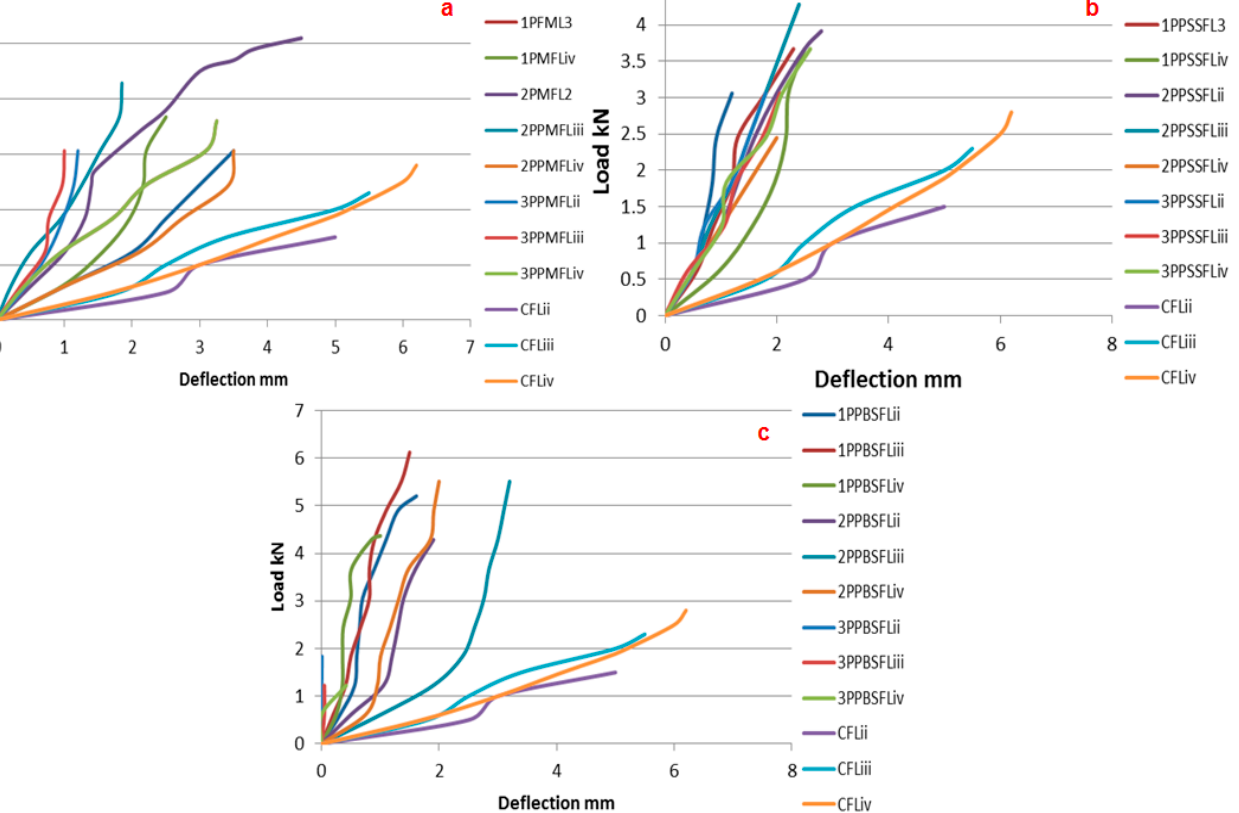
Figure 9. Load deflection behaviour of ( a ) marquisette, ( b ) small sandfly, and ( c ) big sandfly net polypropylene warp knitted reinforced ferrocement composites.